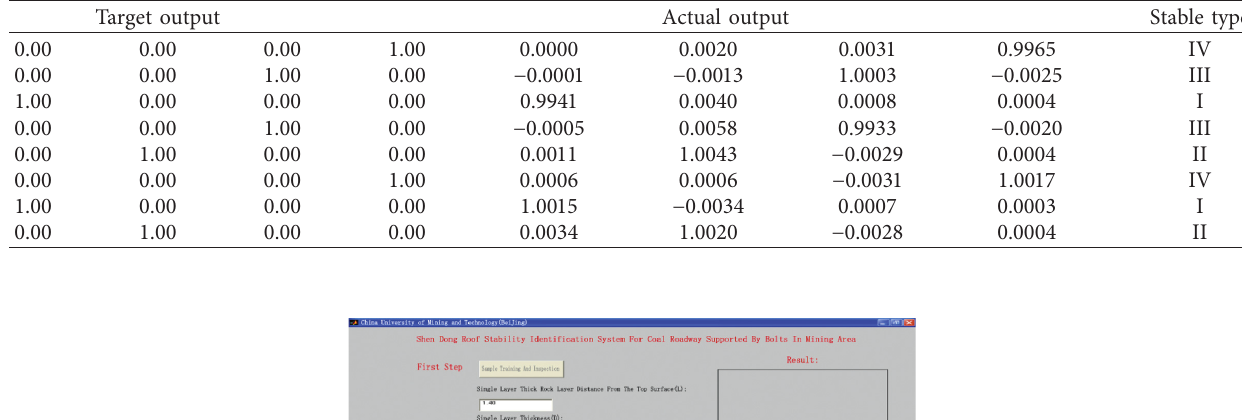
Table 5: Excepting output and real output.